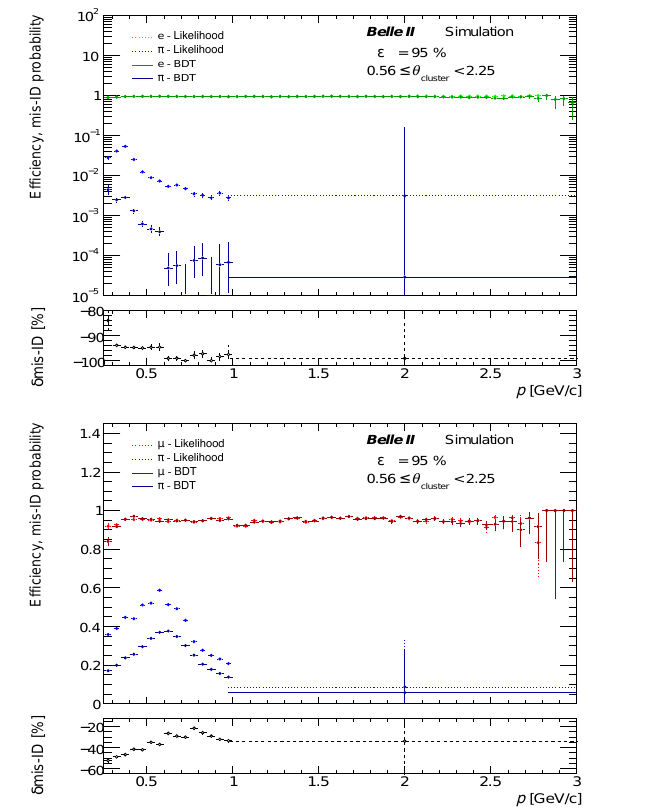
Figure 3. Lepton identification e ffi ciency and π → e (top), π → µ (bottom) mis-identification prob- ability f as a function of p for likelihood-based and BDT-based PID, in the ECL barrel region. The cut on the classifier is arbitrarily chosen to result in a flat 95% average e ffi ciency for correctly iden- tifying e and µ in each of the three momentum categories. The quantity shown in the bottom pad - δ mis − ID = f BDT / f L − 1 - represents the relative di ff erence in mis-identification probability of the BDT method with respect to the likelihood